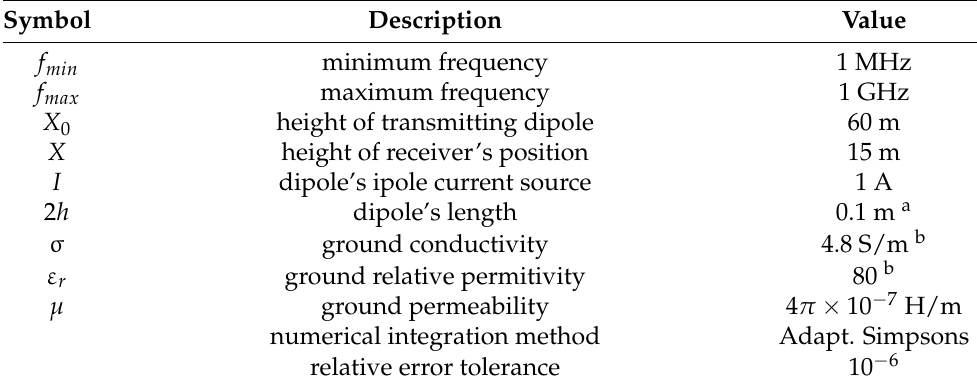
Table 2. Simulations